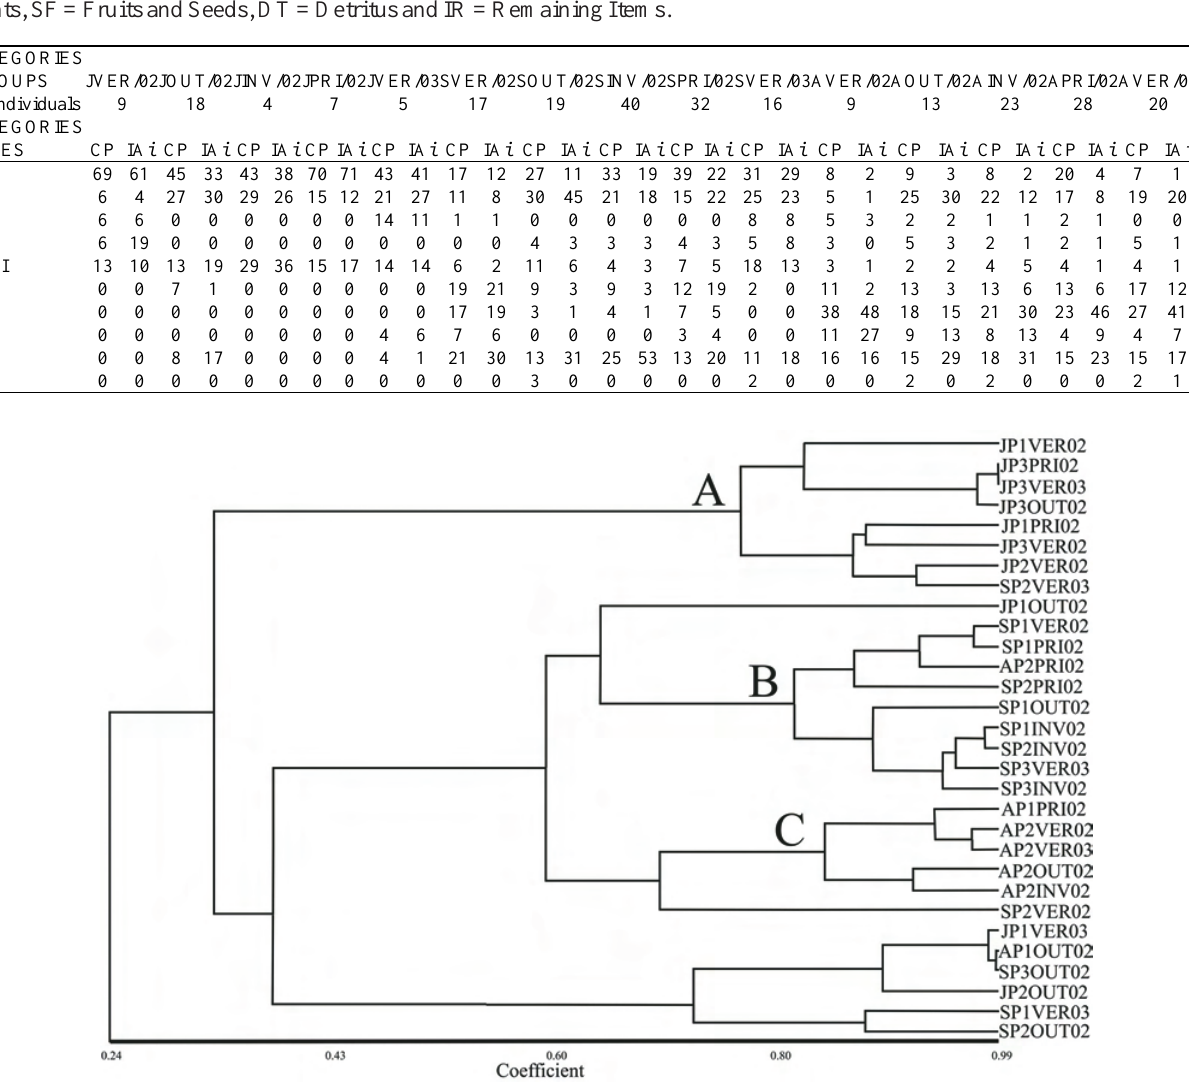
Fig. 3. UPGMA cluster analysis using Morisita-Horn similarity coefficient on the different sizes, sites and seasonal groups. Total length (Lt) categories compared were Juveniles (J = Lt < 3 cm), Semi-adults (S = 3 < Lt < 8 cm) and Adults (A = Lt > 8 cm). The three sites sampled along the catchment were: site 1 (P1), an upstream first order section of the basin near its spring; site 2 (P2), a second order middle section of the basin; and site 3 (P3), a downstream third order section of the basin. The seasons are: VER=summer (December, January and February), OUT=Autumn (March, April and May), INV=Winter (June, July and August), and Spring=PRI (September, October, November). A (> 70 % similarity) = with a predominance of Autochthonous Insects, Allochthonous Insects and Non Identifiable Arthropod Parts; B (> 80 % similarity) = with a predominance of Detritus and Allochthonous and Autochthonous Insects; and C (> 80 % similarity)= with a predominance of Allochthonous plants and